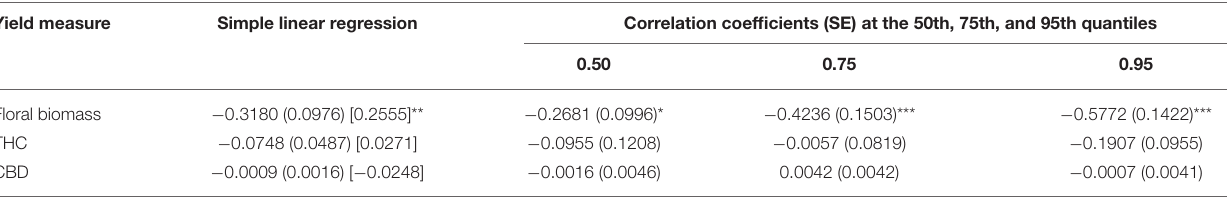
TABLE 2 | Linear quantile regression of the timing of photoperiod switches with floral biomass ( n = 29), THC concentration ( n = 50), and CBD concentration ( n = 31). Yield measure Simple linear